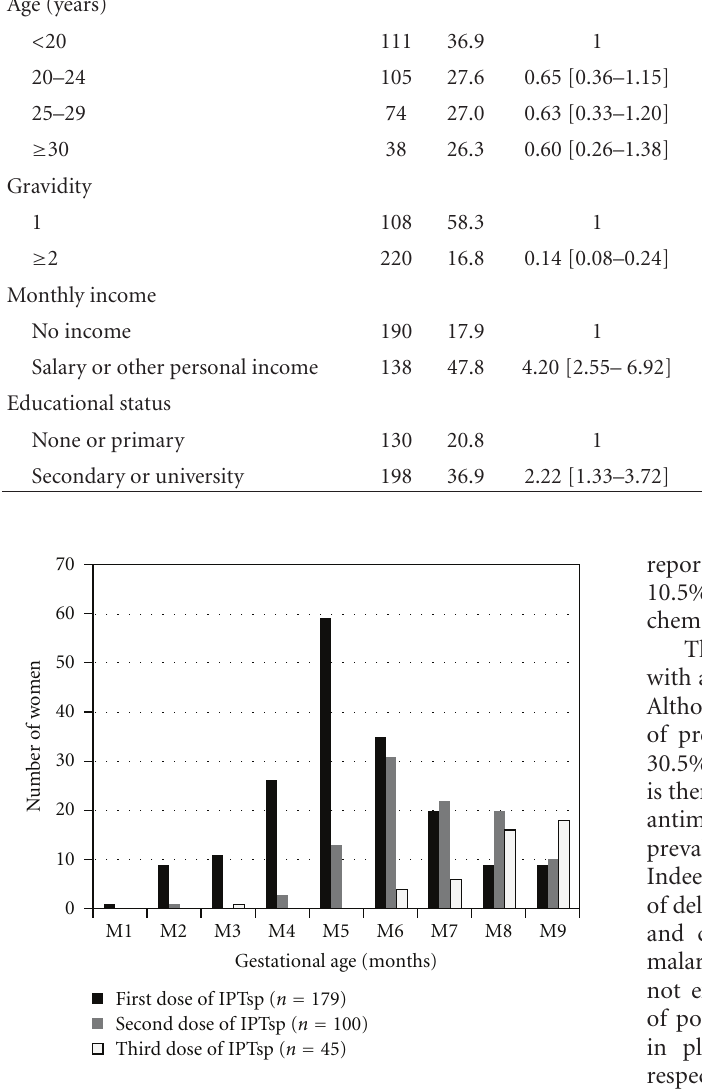
Figure 3: Distribution of intermittent preventive treatment with sulfadoxine-pyrimethamine (IPTsp) doses by gestational age, Sep- tember 2009, Central African